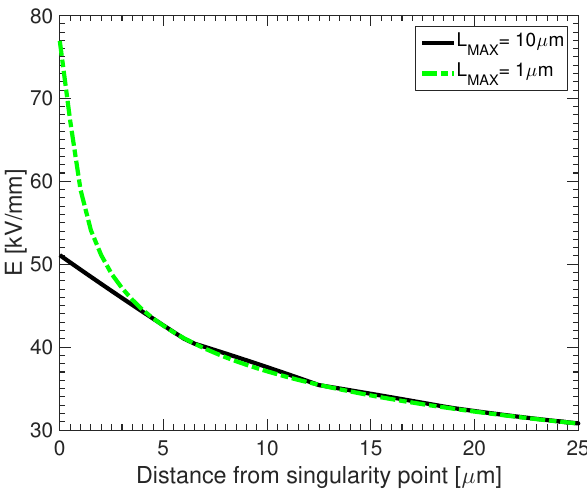
Figure 4: Electric field profiles along the “dielectric 1”- “dielectric 2” interface for L MAX =10 µ m (continuous line) and L MAX = 1 µ m (dot-dashed line). E MAX is located at the singularity point, then E decreases with increased distance from singularity.